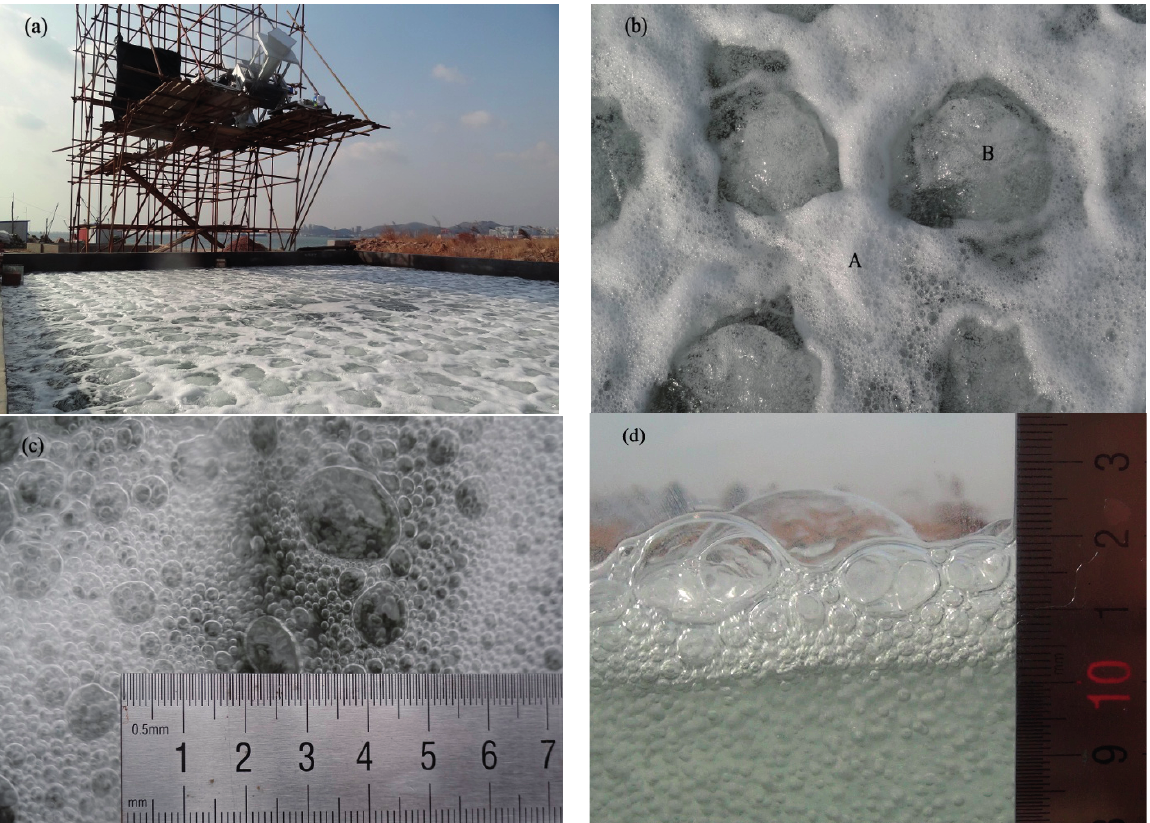
Figure 1. Photography of foam emissivity experiment: ( a ) experimental scene; ( b ) image of foam region (denoted by “A”) and air-water mixture region (region denoted by “B”); ( c ) top view of air bubble size; ( d ) side view of foam thickness and air bubble